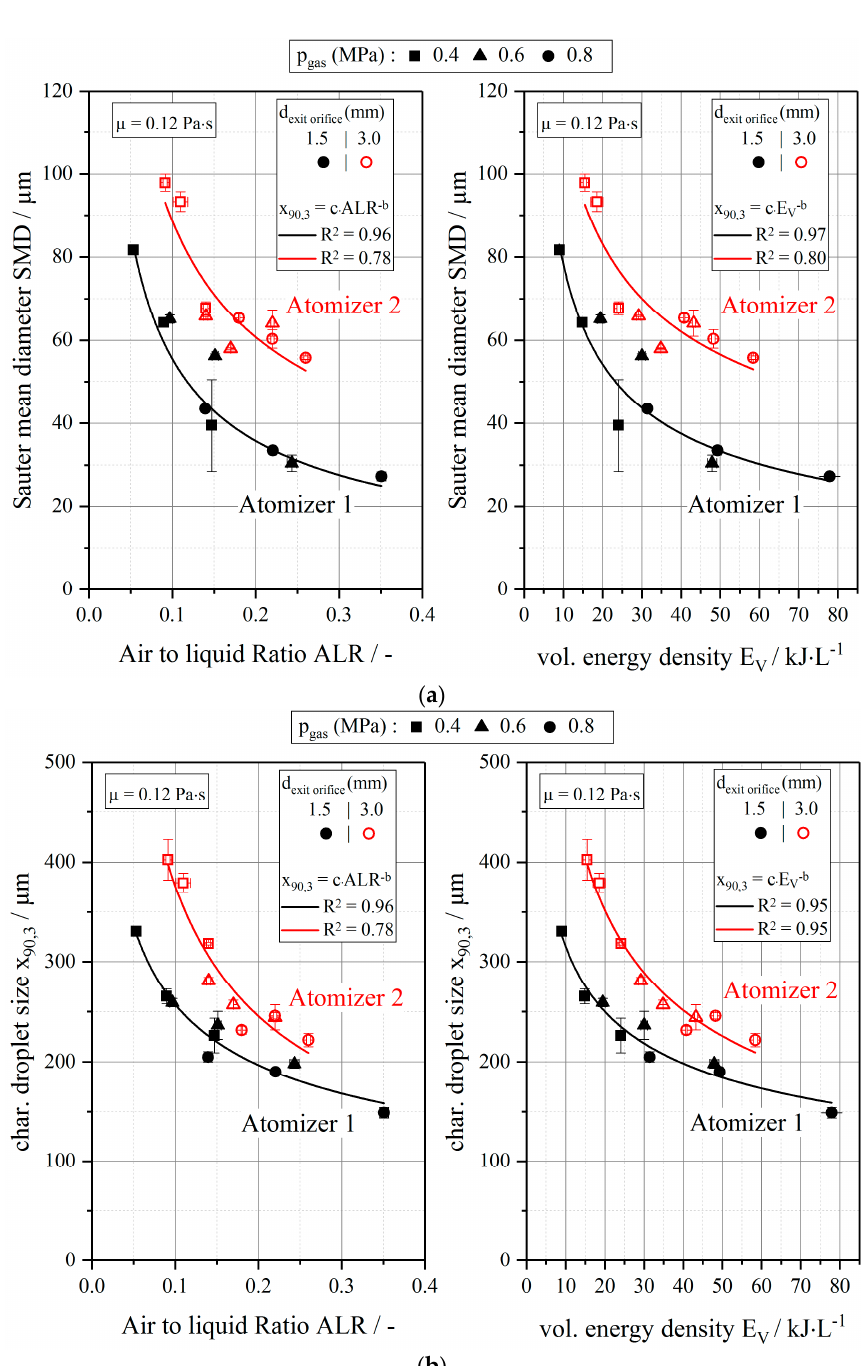
Figure 4. ( a ). SMD in dependency of ALR (left) and E V (right) at µ = 0.12 Pa ∙ s, using atomizers with exit orifice diameters of 1.5 mm (atomizer 1, Q L = 20–40 L ∙ h − 1 ; black filled simbols) and 3.0 mm (atomizer 2, Q L = 100–140 L ∙ h − 1 ; red empty symbols). Applied gas pressures are 0.4 MPa (squares), 0.6 MPa (triangles), and 0.8 MPa (circles). ( b ) Characteristic droplet size x 90,3 in dependency of ALR (left) and E V (right) at µ = 0.12 Pa ∙ s, using atomizers with exit orifice diameters of 1.5 mm (atomizer 1, Q L = 20–40 L ∙ h − 1 ; black filled simbols) and 3.0 mm (atomizer 2, Q L = 100–140 L ∙ h − 1 ; red empty symbols). Applied gas pressures are 0.4 MPa (squares), 0.6 MPa (triangles), and 0.8 MPa (circles).